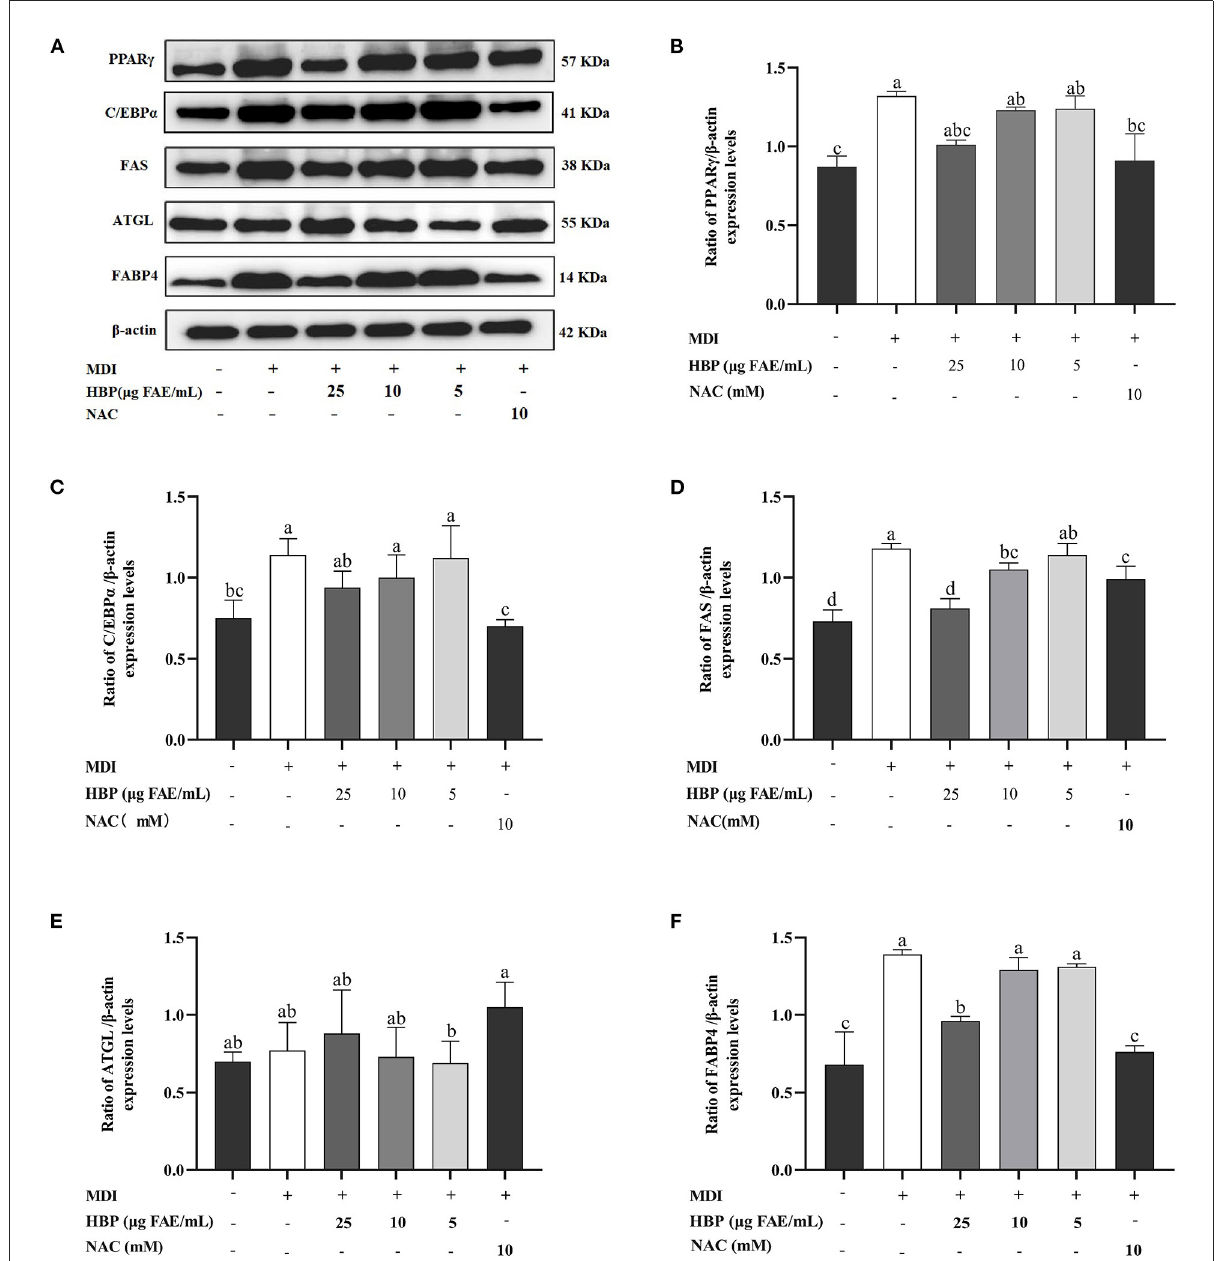
FIGURE7 Effect of HBP extract on the expression of adipogenesis-associated genes in 3T3-L1 adipocytes. (A) The protein expression of PPAR γ , C/EBP α , FAS, ATGL, FABP4, and β -actin and (B-F) the relative protein levels were measured by Western blot analysis. Data are expressed as mean n 3, and different lowercase letters indicate significant differences ( p < =